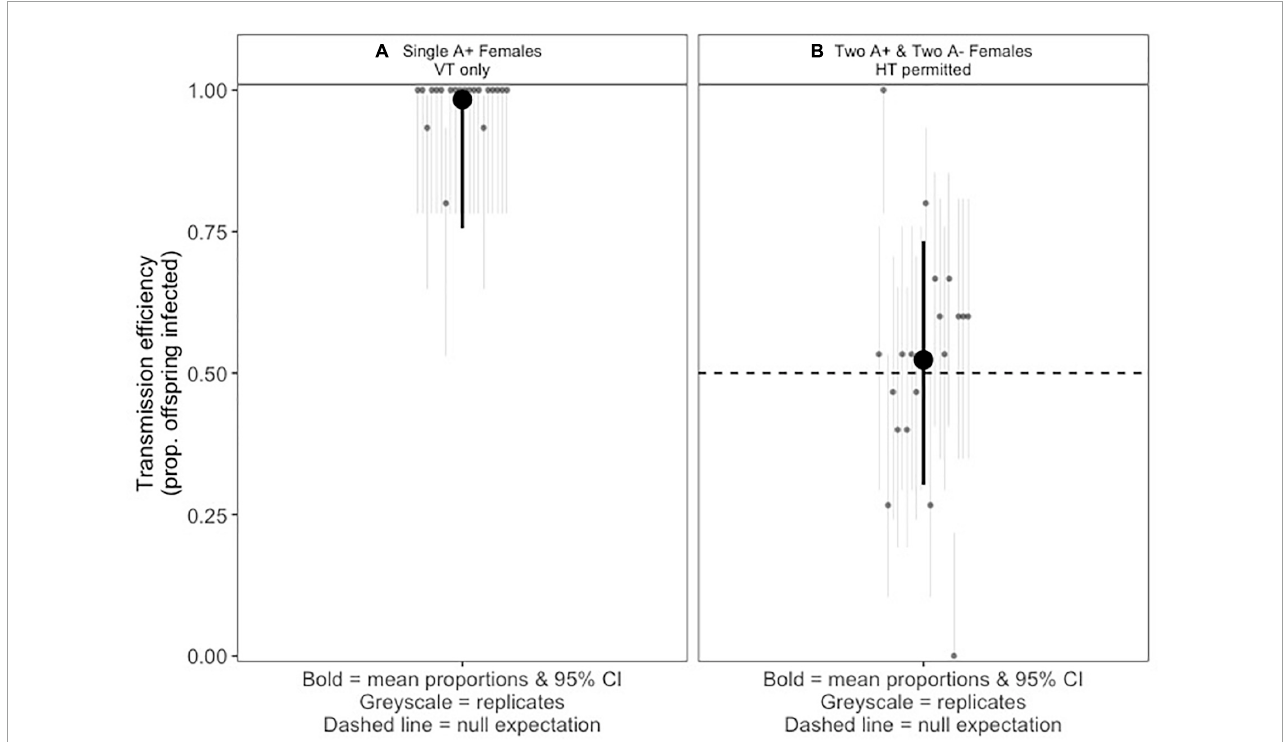
FIGURE1 (A) Vertical transmission of Arsenophonus nasoniae a Pv in Pachycrepoideus vindemmiae . Light gray points and errors represent infection prevalence of 20 replicate broods laid by single infected mothers (15 randomly selected female offspring screened from each brood). Dark point and errors show the mean proportion of progeny infected and mean 95% confidence interval calculated using the logit method. (B) Fraction of P. vindemmiae progeny carrying A. nasoniae a Pv when half of mother wasps carry a Pv. Pale points and errors represent infection prevalence in 20 replicate broods co-laid by 2:2 infected:uninfected mothers (15 randomly selected female offspring screened from each brood). Dark points and errors represent mean infection prevalence and upper and lower 95% confidence intervals calculated with the logit method. Dashed line illustrates the null expectation of 50% infection if there is no horizontal transmission (HT) and no (dis)advantage to symbiont